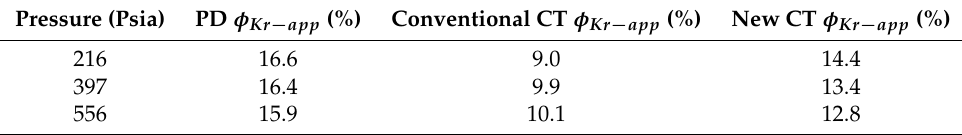
Table 2. Wolfcamp core Kr porosity results comparison using pulse decay (PD), conventional CT, and new CT